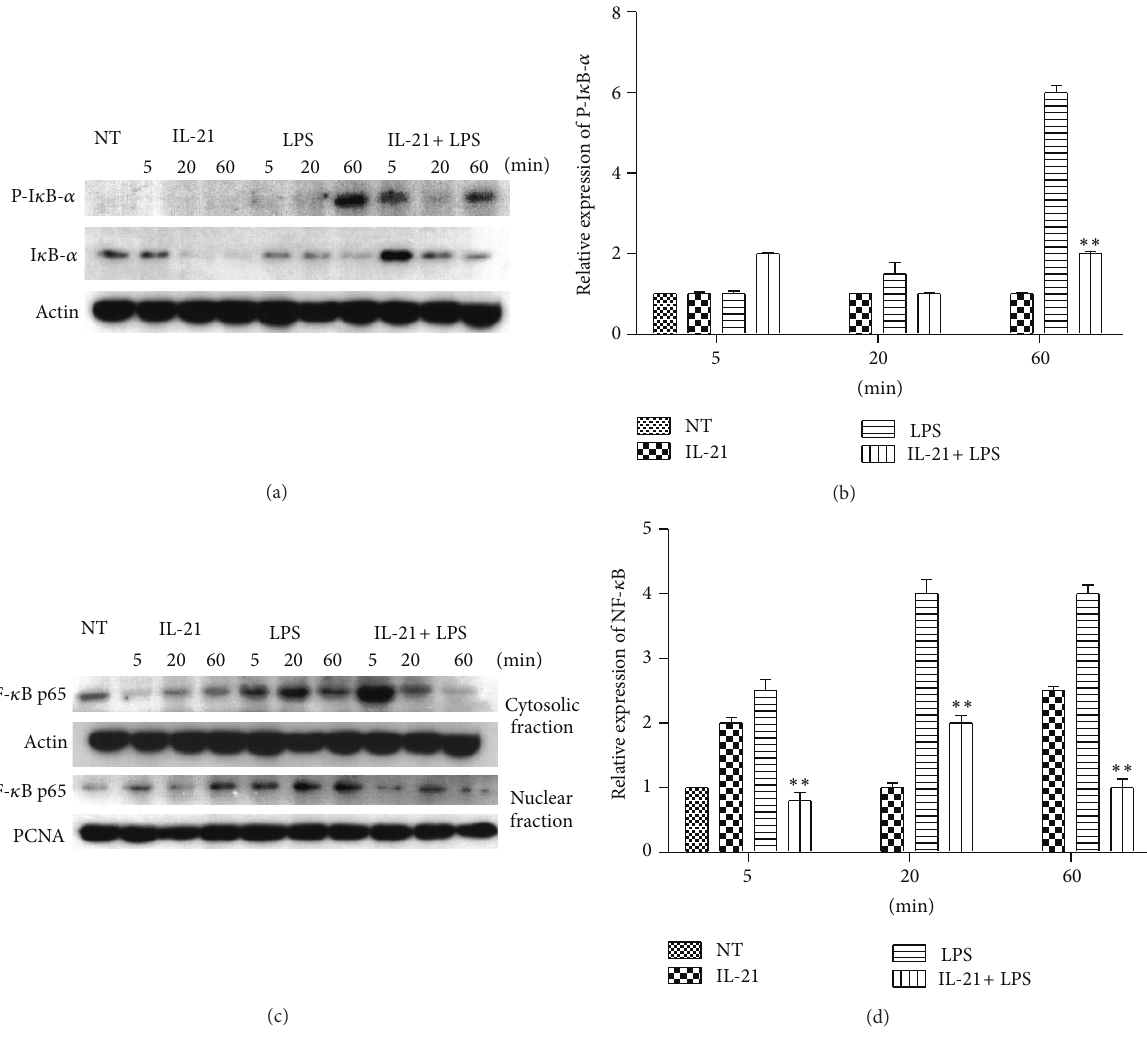
Figure 5: Effects of IL-21 on LPS-induced NF- 𝜅 B signal pathway in mouse peritoneal macrophages. Macrophages ( 5 × 10 6 ) were incubated with IL-21 (100ng/mL) in the presence or absence of LPS (100ng/mL) for 5 min, 20min, and 60min. Nuclear and cytosolic proteins from macrophages were analyzed by Western blot with specific antibodies. Detection of Actin and PCNA was estimated as protein-loading control for each lane. Values are presented as mean ± SD of three independent experiments. ∗ 𝑃 < 0.05 , ∗∗ 𝑃 < 0.01 compared with the LPS